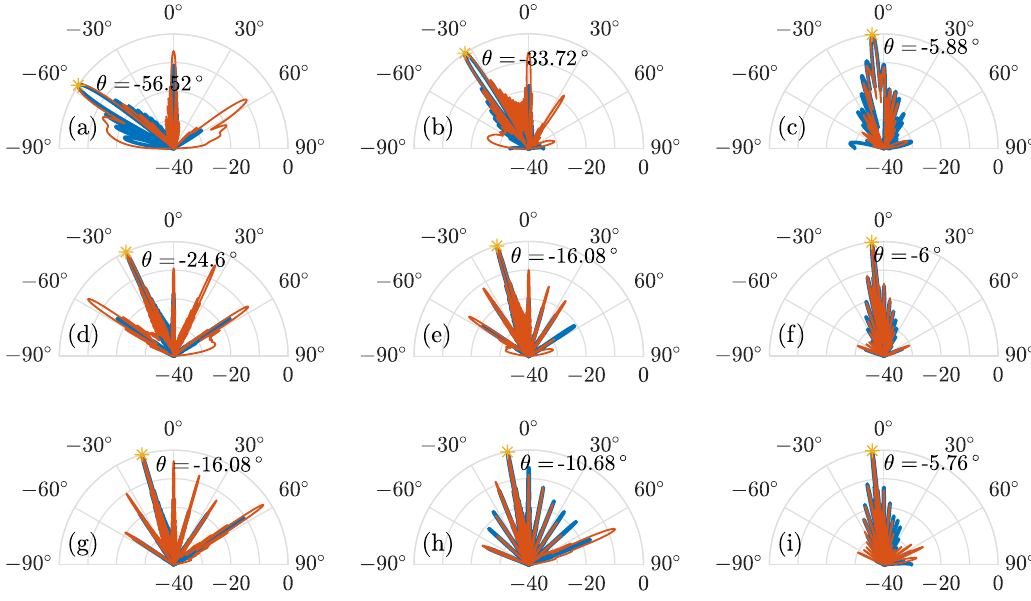
Figure 12. Simulated (in red) and calculated (in blue) radiation pattern at ( a ) the maximum steering angle at 0.3THz, ( b ) the middle of the steering range at 0.3THz, and ( c ) the minimum steering angle of the steering range at 0.3THz. Simulated radiation pattern at ( d ) the maximum steering angle at 0.6 THz, ( e ) the middle of the steering range at 0.6THz, and ( f ) the minimum steering angle of the steering range at 0.6THz. Simulated radiation pattern at ( g ) the maximum steering angle at 0.9THz, ( h ) the middle of the steering range at 0.9THz, and ( i ) the minimum steering angle of the steering range at